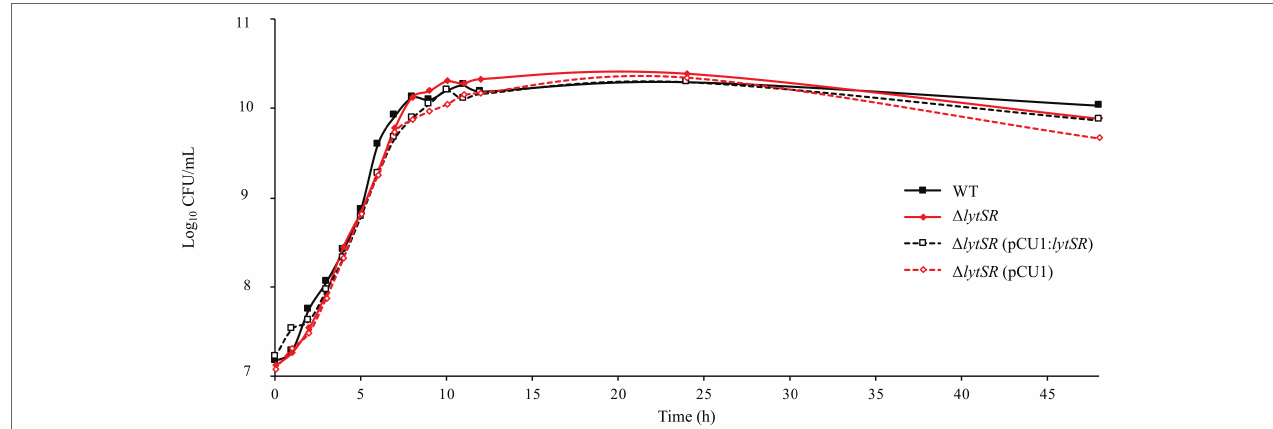
FIGURE 1 | Growth curves of S. lugdunensis WT, Δ lytSR, and complemented strains. Bacterial cultures were grown in TSB at 37 ° C. Growth was monitored by measuring OD